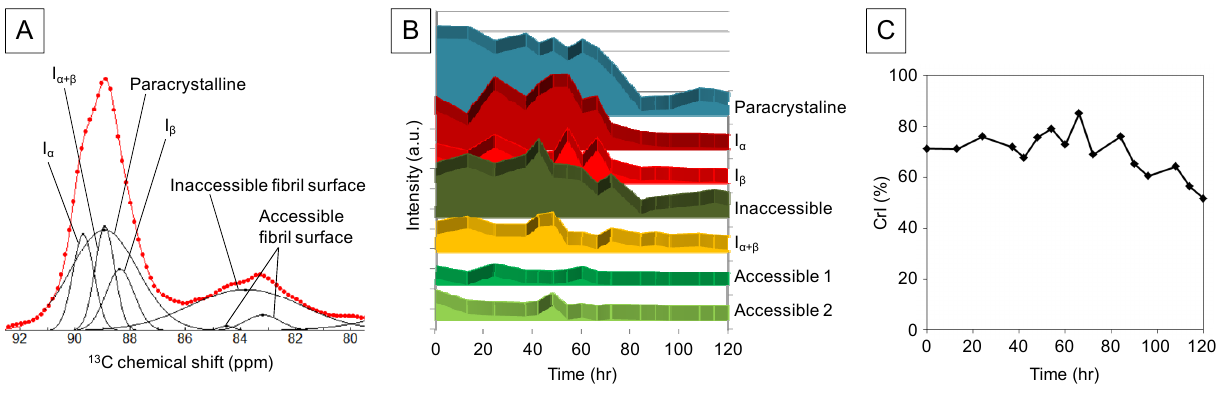
representative sample acquired after 13 h. The red dots and the red and black lines represent the raw NMR spectral data, the fitting model, and functions of each allomorph, respectively. ( B ) Intensity fluctuations of each allomorph determined by spectral fitting analysis of the 13 C-CP/MAS-NMR spectra. ( C ) Time-dependent fluctuation of